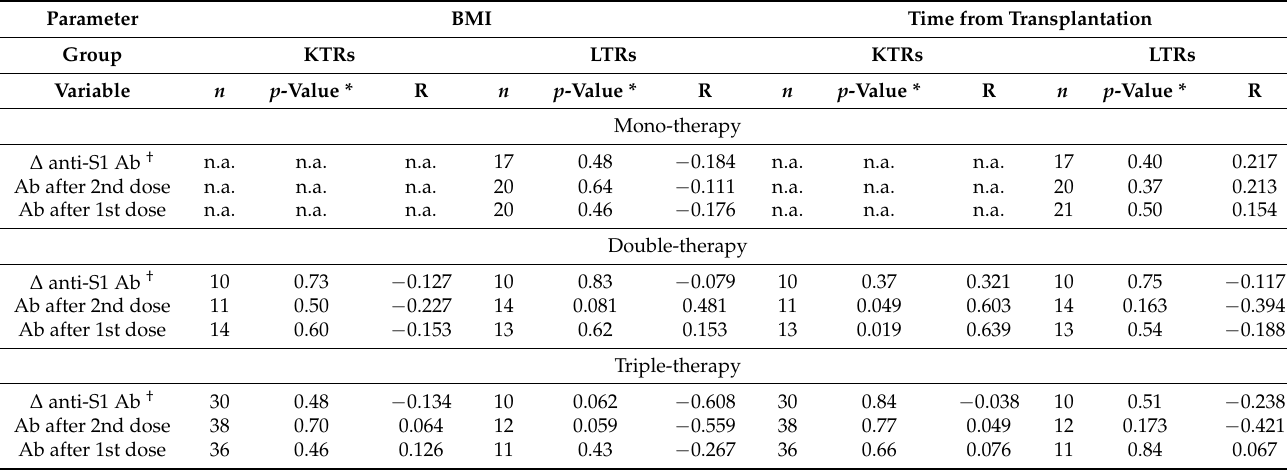
Table A3. Associations of SARS-CoV-2 spike protein Ab concentration (AU/mL) after BNT162b2 vaccination with BMI and time from transplantation in KTRs and LTRs depending on the number of immunosuppressive drugs. Parameter BMI Group